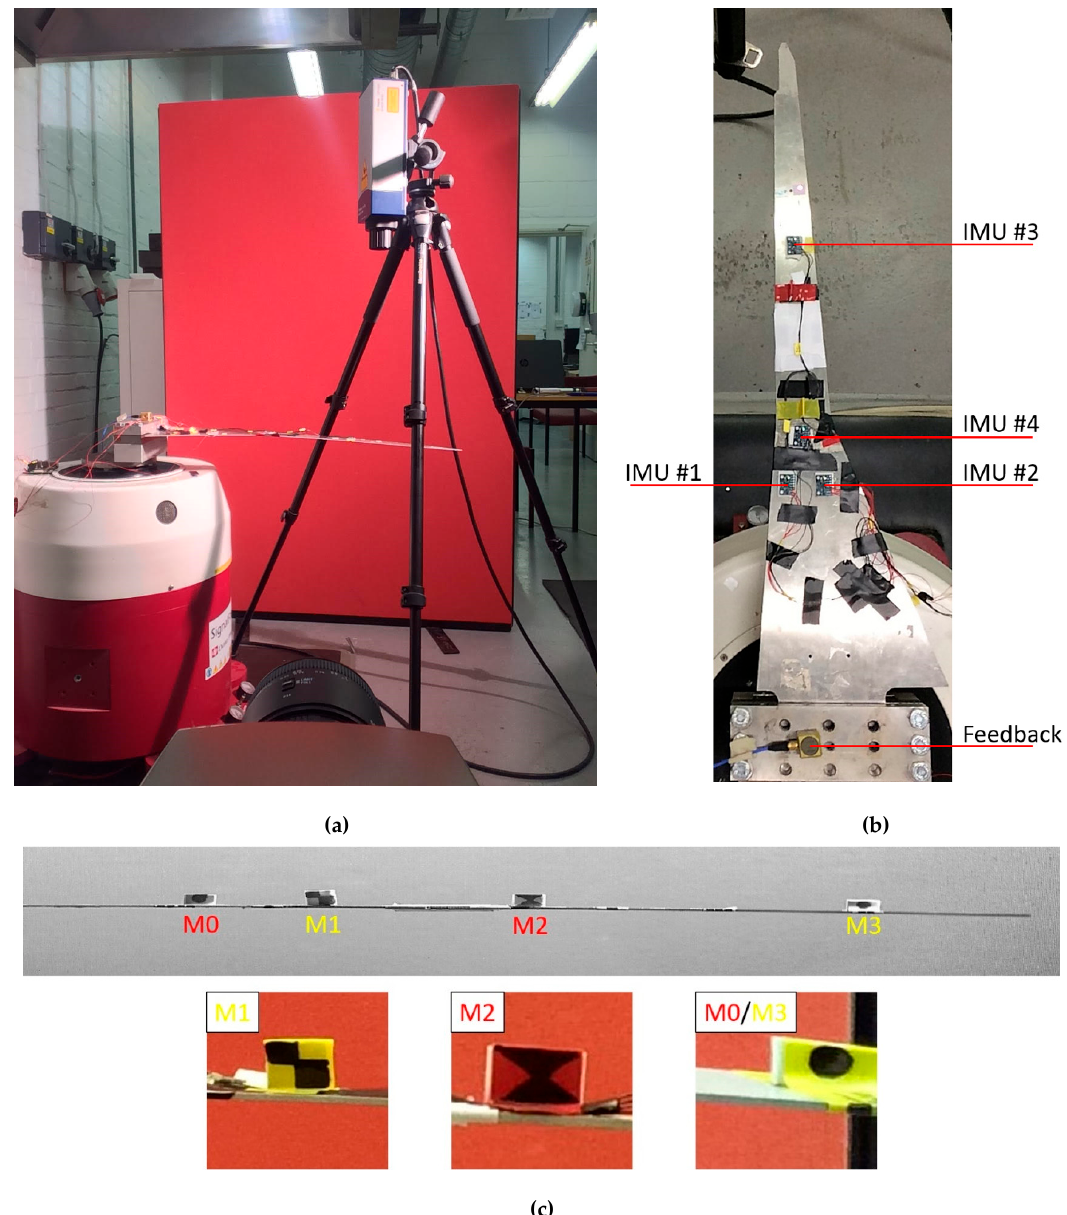
Figure 2. (a) Experimental setup: Modal shaker, high-speed video camera and laser velocimeter. Laser velocimeter was used to check the frequency at a given point relatively close to the spar tip. A solid red curtain was used to provide a uniform background. An open-faced lighting fixture with tungsten light source was used to provide strong illumination, near perfect colour rendition and to avoid nefarious effects related to AC illumination. (b) Top view of the four inertial measurement unit (IMU) sensors for the loaded condition, of the feedback accelerometer and of the several markers attached on the top surface of the spar. Markers M0 and M3 were removed during tests with IMUs attached. A red laser dot is also clearly visible. (c) Close-up of the air wing spar trailing edge, with no sensors but all four markers attached. M0, not shown, has the same pattern as M3 but on a red background. The trailing edge of the spar was completely included in the plane of focus.